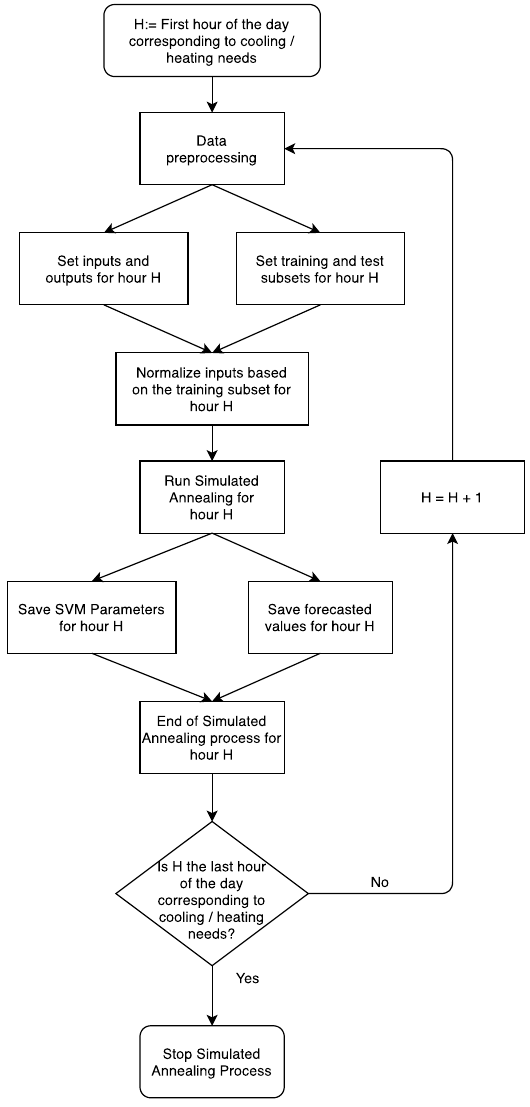
Figure 3. Simulated annealing (SA) flowchart depicting approach used to enhance support vector machines (SVM) models.